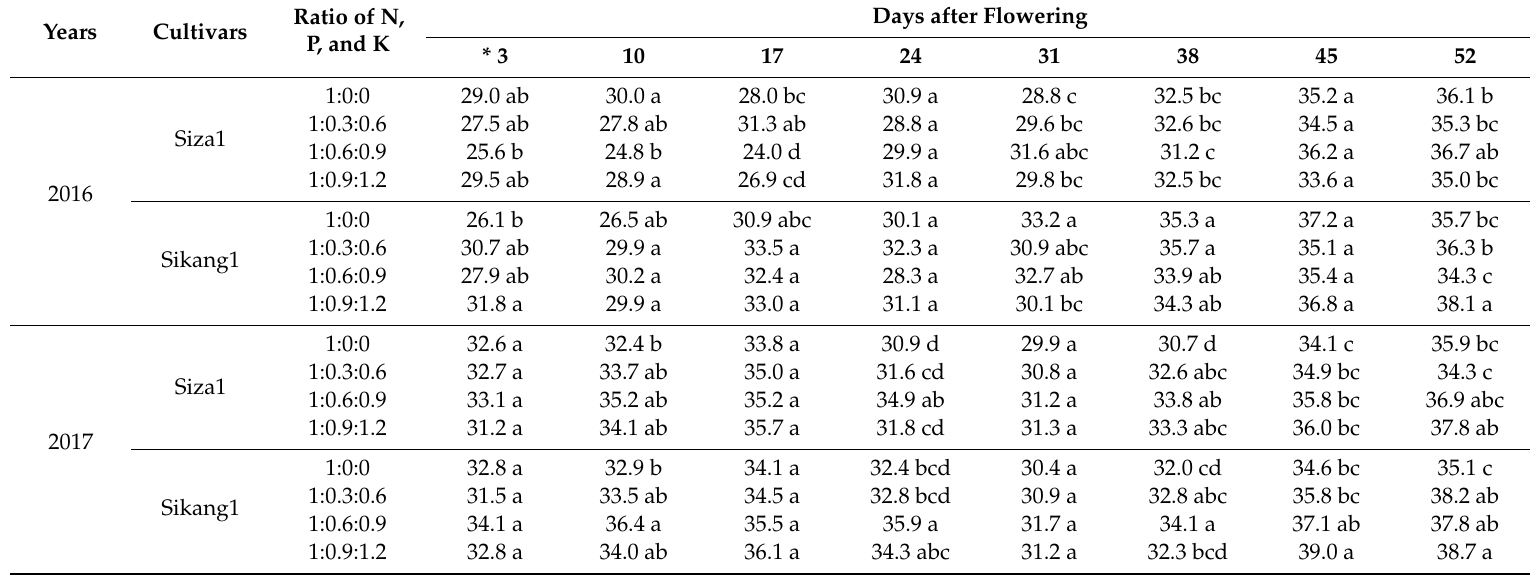
Days after Flowering